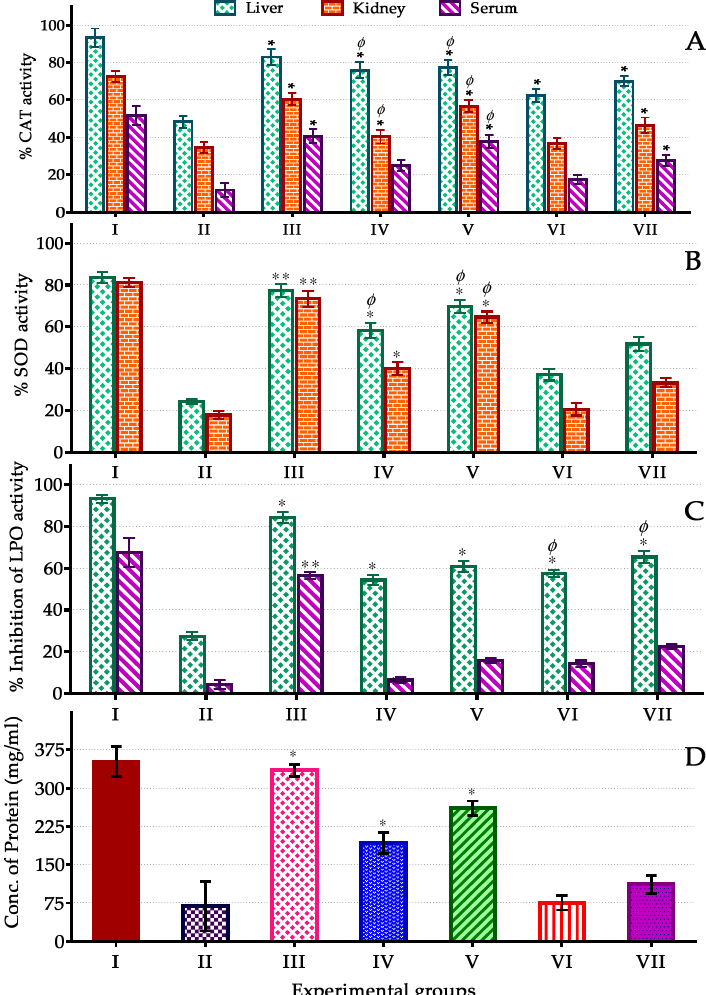
Figure 8. In-vivo antioxidant activities of unprocessed and processed lupin flours. The CAT, SOD, LPO activities and protein contents in serum, liver and kidney samples of CCl 4 treated oxidative mice model after administration of processed and unprocessed flours of lupin cultivar Mandelup. Values were expressed as mean ± SEM where n = 6 mice in each groups and single and double stars indicated statistical significances (*p < 0.05; **p < 0.01) vs. normal control group; Φ p < 0.05 indicated significance vs. standard (by post-hoc Bonferroni test). A, B, C, D indicated activity of CAT (Catalase), SOD (Superoxide dismutase), LPO (Lipid peroxidation) and protein content, respectively. Group I: normal control, II: CCl 4 control, III: standard (silymarin), IV: unprocessed flour (200 mg/kg), V: unprocessed flour (400 mg/kg), VI: processed flour (200 mg/kg) and VI: processed flour (400 mg/kg).